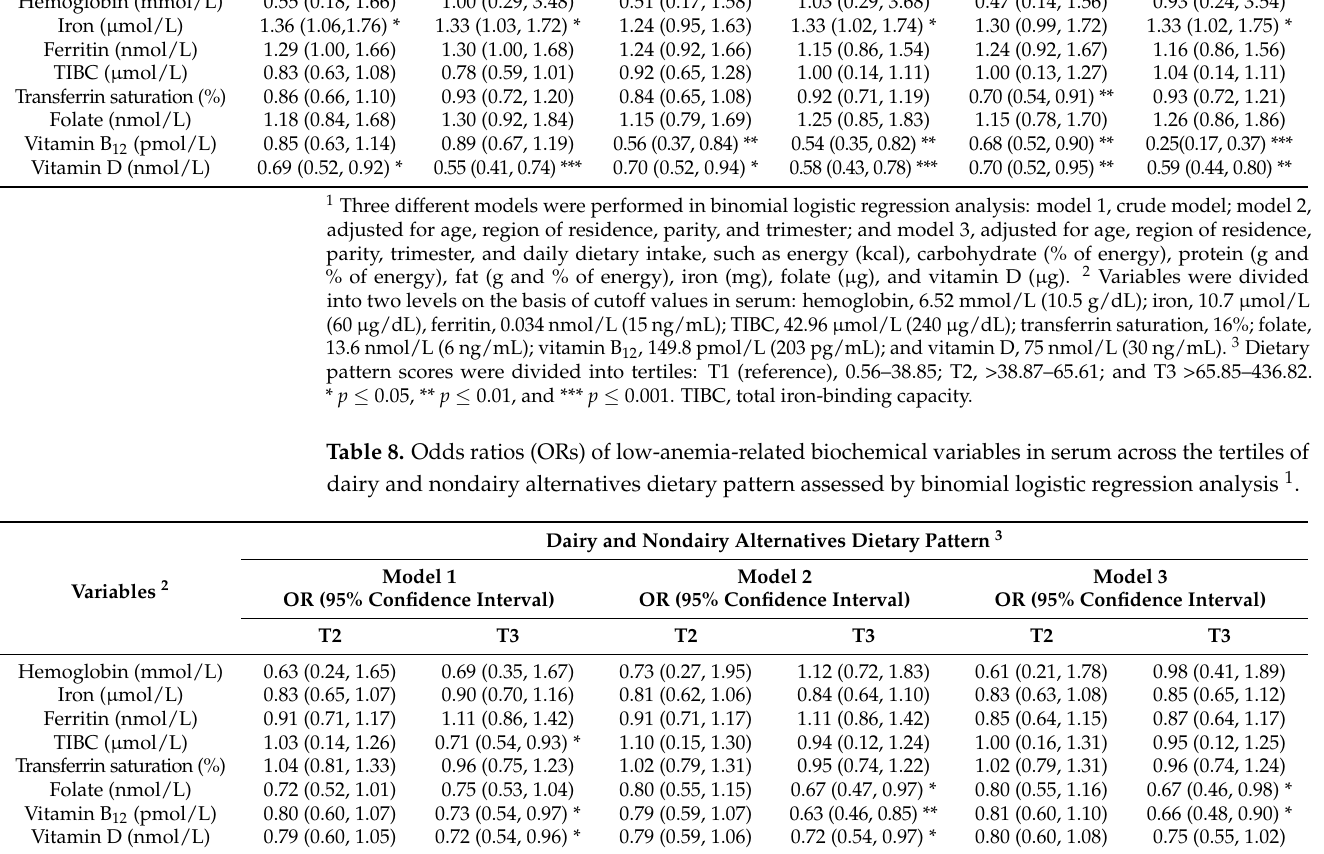
1 Three different models were performed in binomial logistic regression analysis: model 1, crude model; model 2, adjusted for age, region of residence, parity, and trimester; and model 3, adjusted for age, region of residence, parity, trimester, and daily dietary intake, such as energy (kcal), carbohydrate (% of energy), protein (g and % of energy), fat (g and % of energy), iron (mg), folate ( µ g), and vitamin D ( µ g). 2 Variables were divided into two levels on the basis of cutoff values in serum: hemoglobin, 6.52 mmol/L (10.5 g/dL); iron, 10.7 µ mol/L (60 µ g/dL), ferritin, 0.034 nmol/L (15 ng/mL); TIBC, 42.96 µ mol/L (240 µ g/dL); transferrin saturation, 16%; folate,